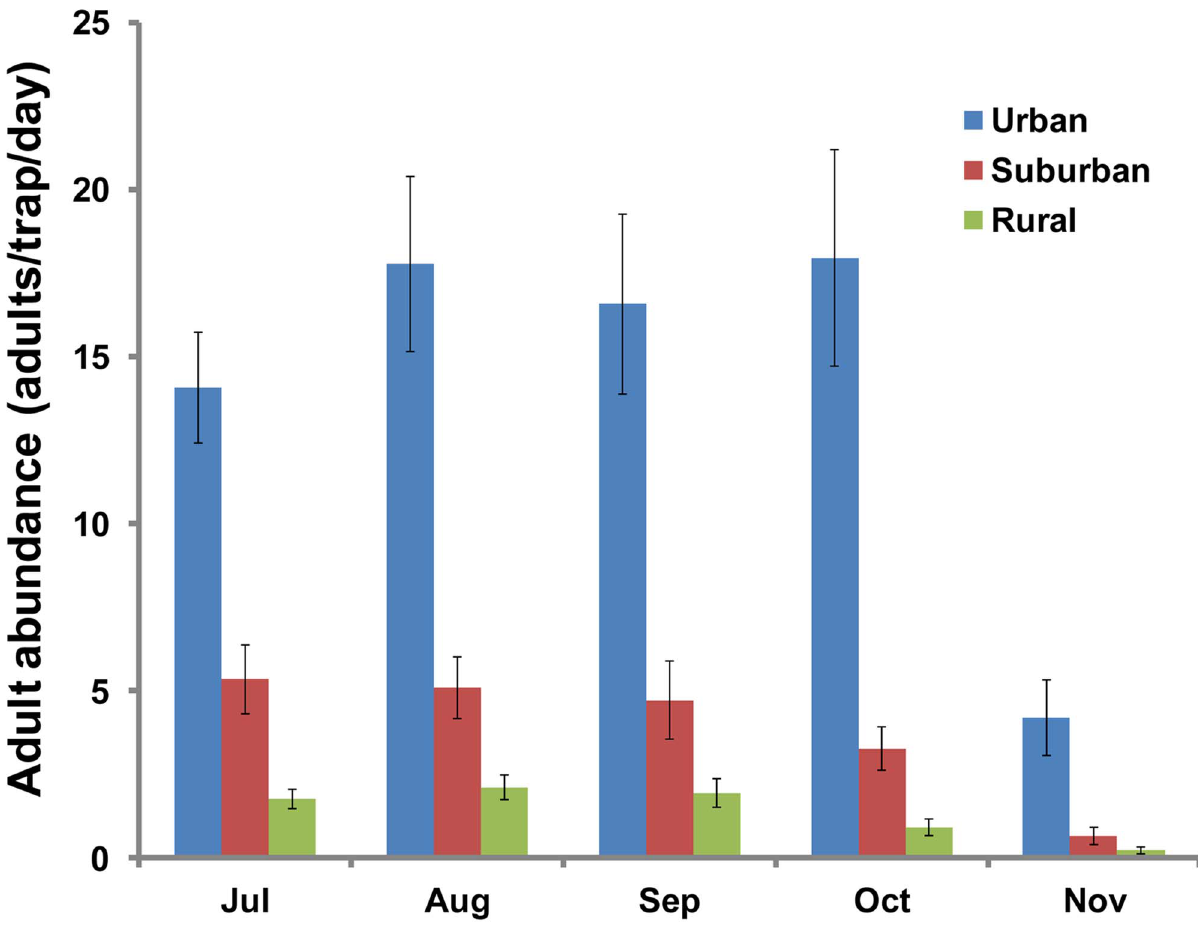
Figure 3. Mean density of adult Aedesalbopictus (adults/trap/night) in the three study sites from July to November. Square root transformed data were used, and the 95% confidence interval is shown as a bar. between males and females (Figure 6, Table S2). Survival curves